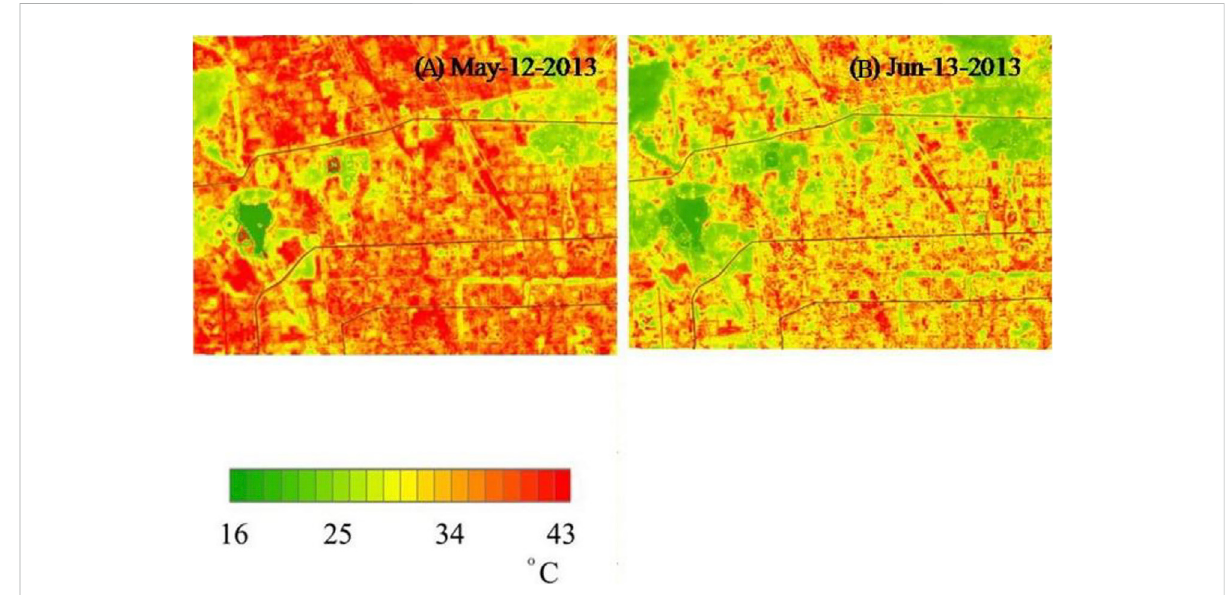
FIGURE 2 Dynamics of Ts patterns in the study area in (A) May and (B) June 2013 based on the surface energy balance method using Landsat-8 satellite data. Each date had different ranges.